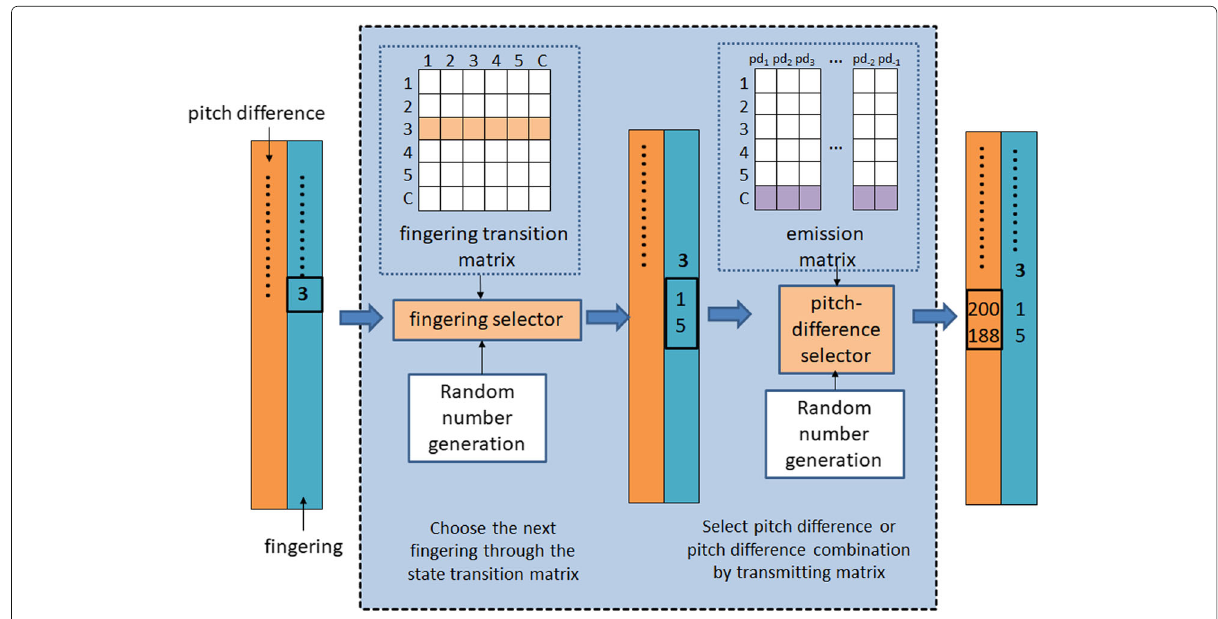
Fig. 6 Principle of the dataset